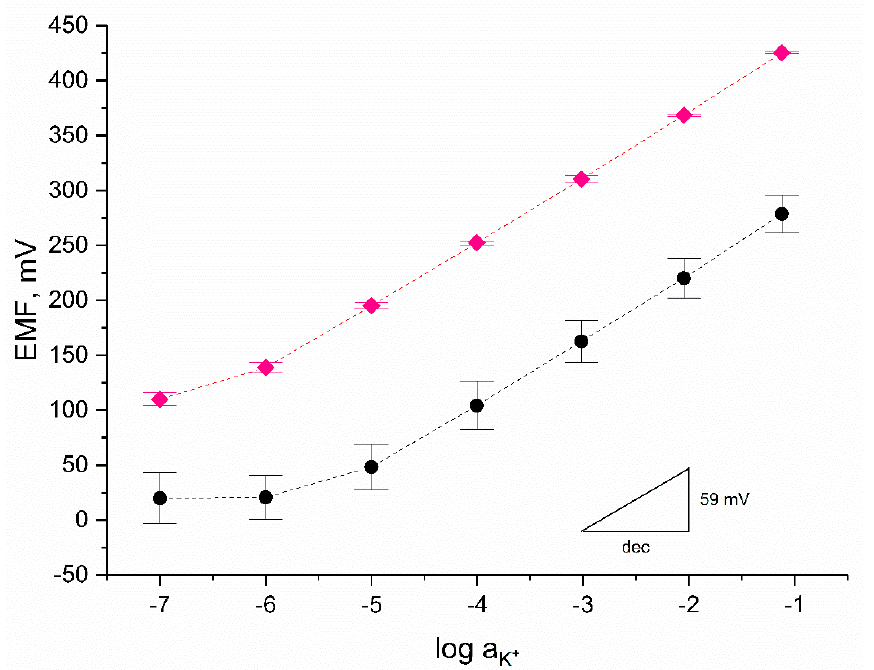
Figure 5. Calibration curves prepared on the basis of average electromotive force (EMF) values of GC/RuO 2 + PEDOT:PSS(THF)/K + -ISM ( ◆ ) and GCD/K+-ISM ( ● ) electrodes measured after 24, 48, and 72 h of conditioning ( n = 3) with error bars depicting repeatability of potentiometric response.